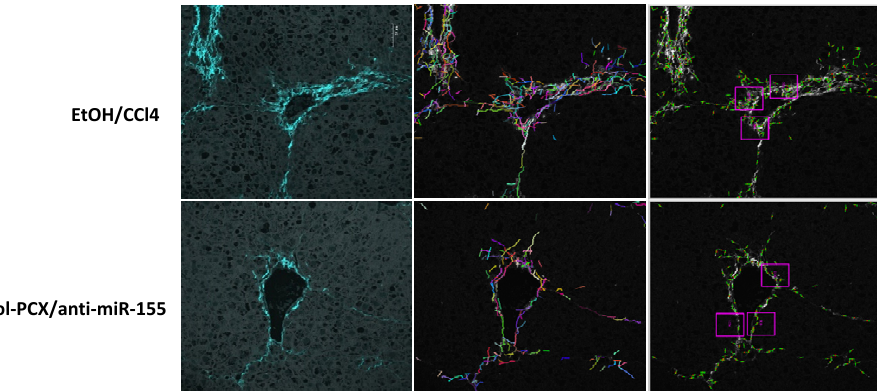
Figure 11. SHG imaging of liver collagen fibers. Representative images from central veins of liver samples with individual pseudocolored collagen fibers identified; pink squares show the 50 μ m ROIs to calculate average collagen fiber counts, quantitative analyses of collagen organization, and